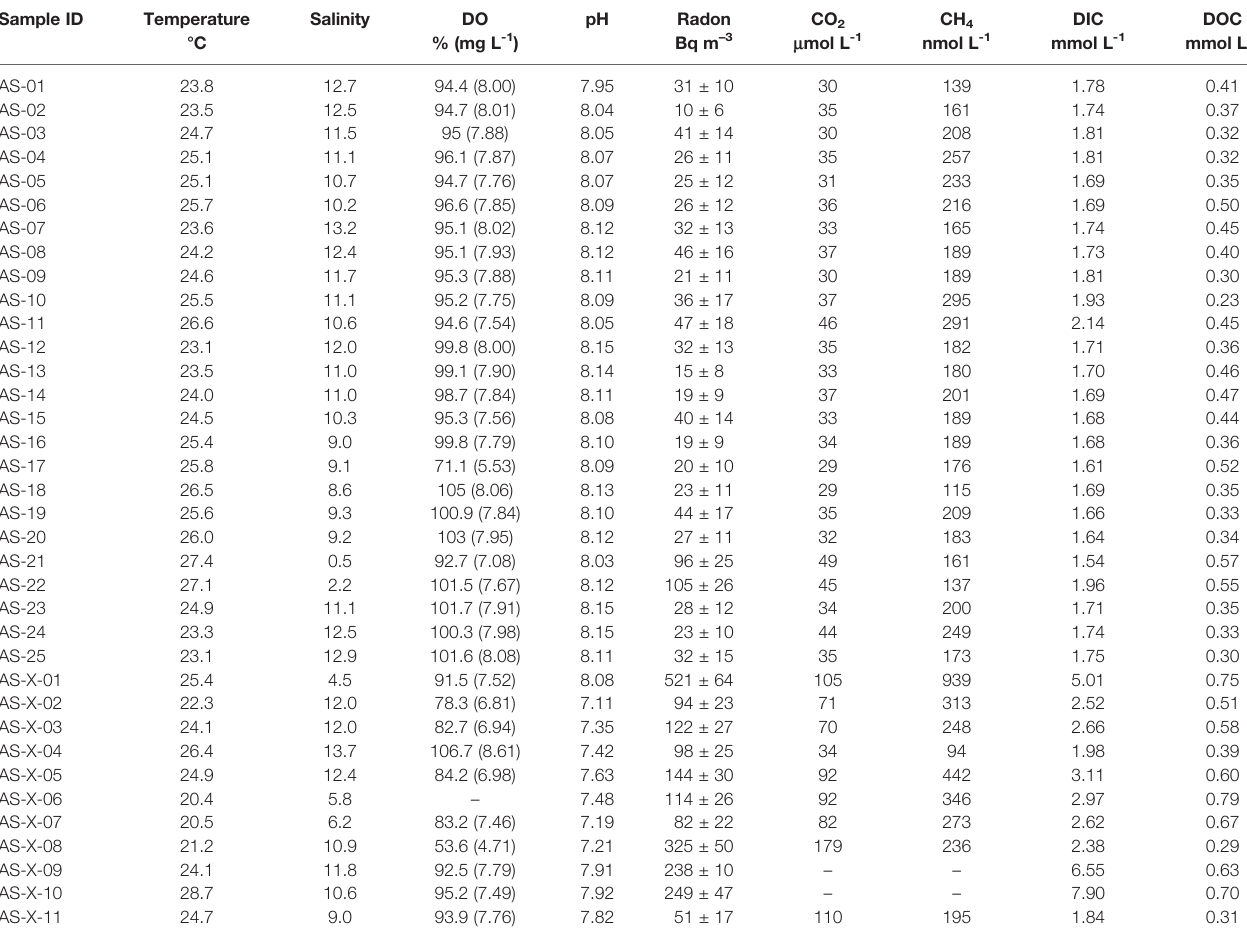
TABLE 1 | Summary of surface water observations. Sample